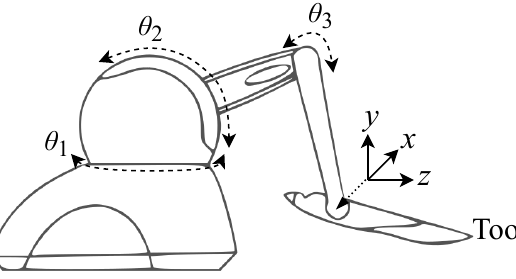
Figure 2. PHANToM Omni—MD and SD.